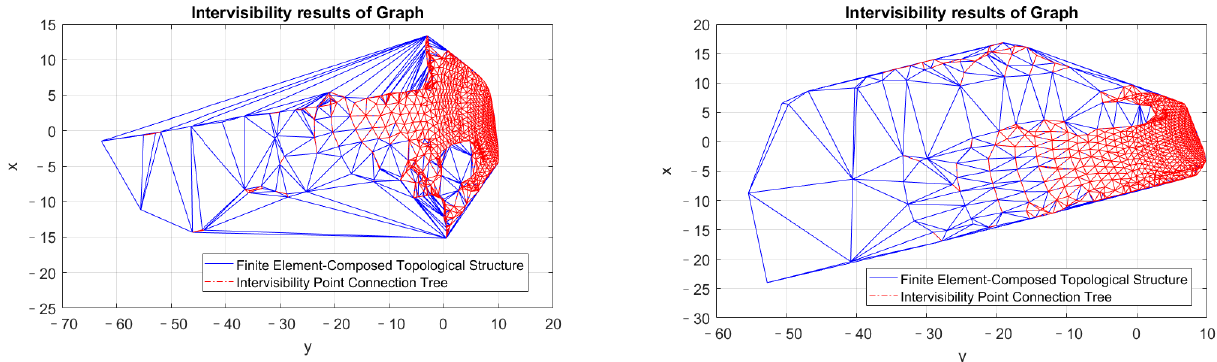
Figure 6. Finite element-composed topological structure with intervisibility.